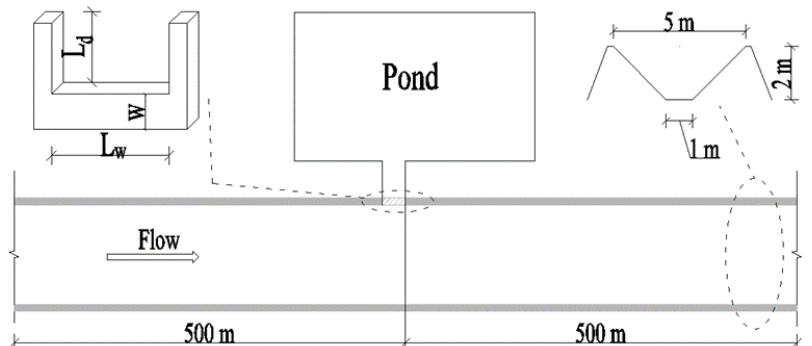
Figure 3. Geometric parameters of an off-line ditch-pond system.